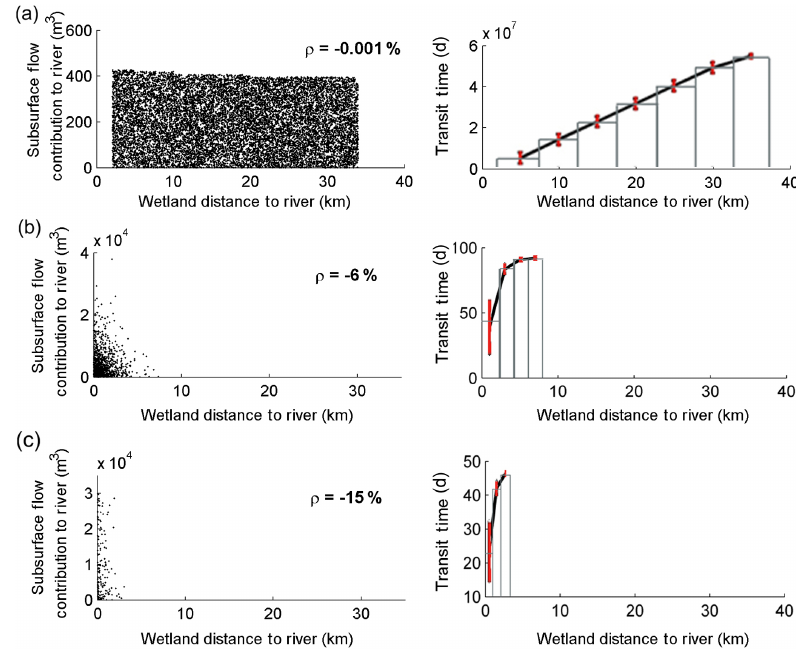
Figure 8. The relationship between flow contribution of each wetland to the North Saskatchewan River and the distance of the wetland to the North Saskatchewan River (left panel), and the relationship between transit time of connection of each wetland to the North Saskatchewan River and the distance of the wetland to the North Saskatchewan River (right panel). In the right panel, the black lines connect the mean value of each distance category and red vertical lines show the standard deviation of each category. Panel (a) shows subsurface flow contribution and connection of each wetland. Flow contribution was calculated for 4 months for each wetland using the steady-state model. Panel (b) shows surface flow contribution in 2013 and connection of each wetland. Flow contribution was calculated for 4 months (1 April to 1 August 2013) using the transient model. Panel (c) shows surface flow contribution in 2009 and connection of each wetland. Flow contribution was calculated for 4 months (1 April to 1 August 2009) using the transient